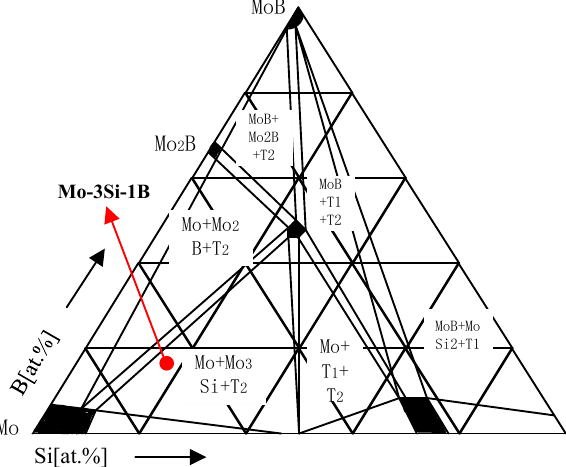
Figure 1. Isothermal section of Mo–Si–B at 1600 °C [1].